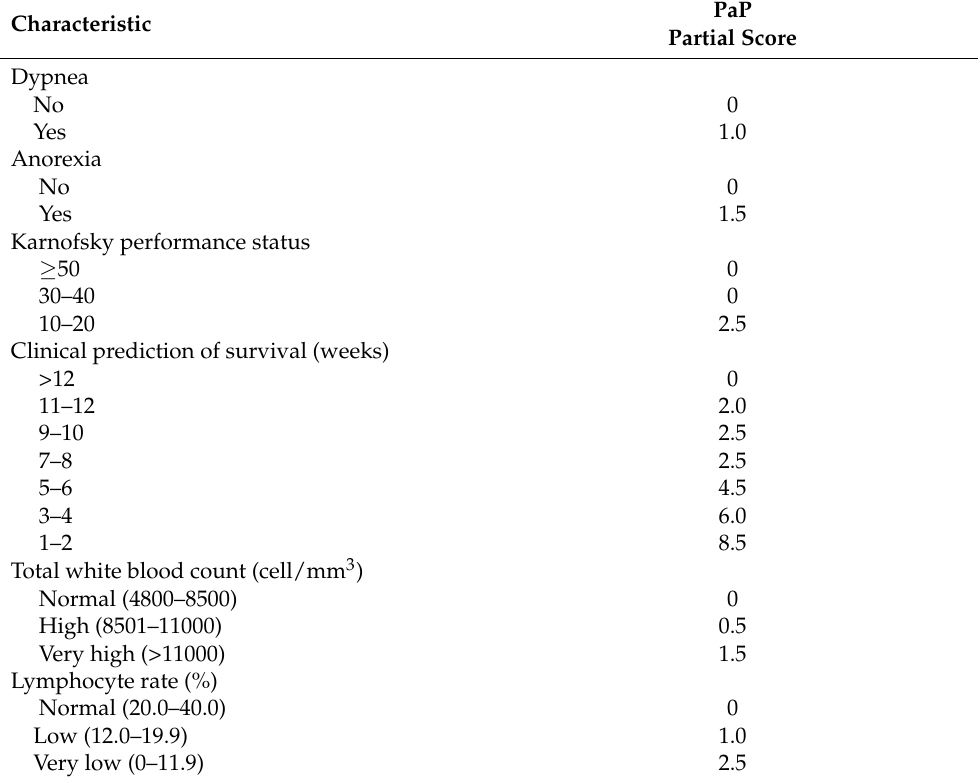
Table 1. Original PaP score and classification of patients in the three risk